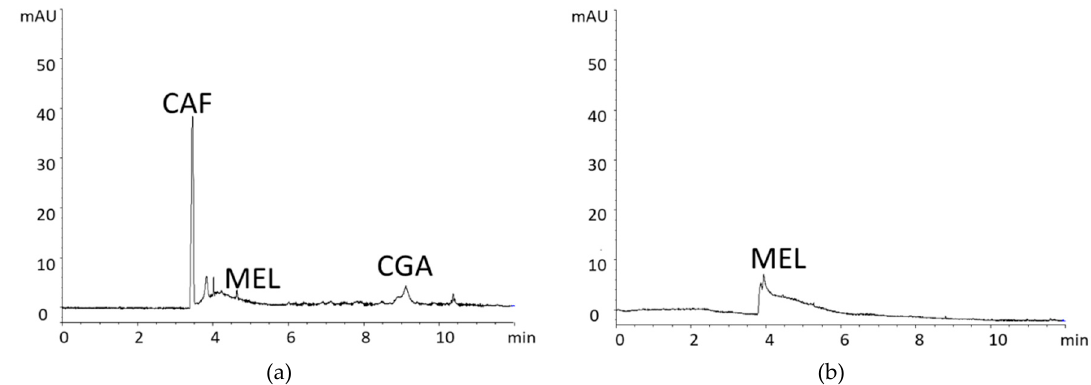
Figure 2. E-gram recorded at 280 nm showing the identified compounds from coffee silverskin (4 mg/mL) ( a ) and melanoidins (4 mg/mL) ( b ). Peak identification: CAF—caffeine; CGA—chlorogenic acid; and